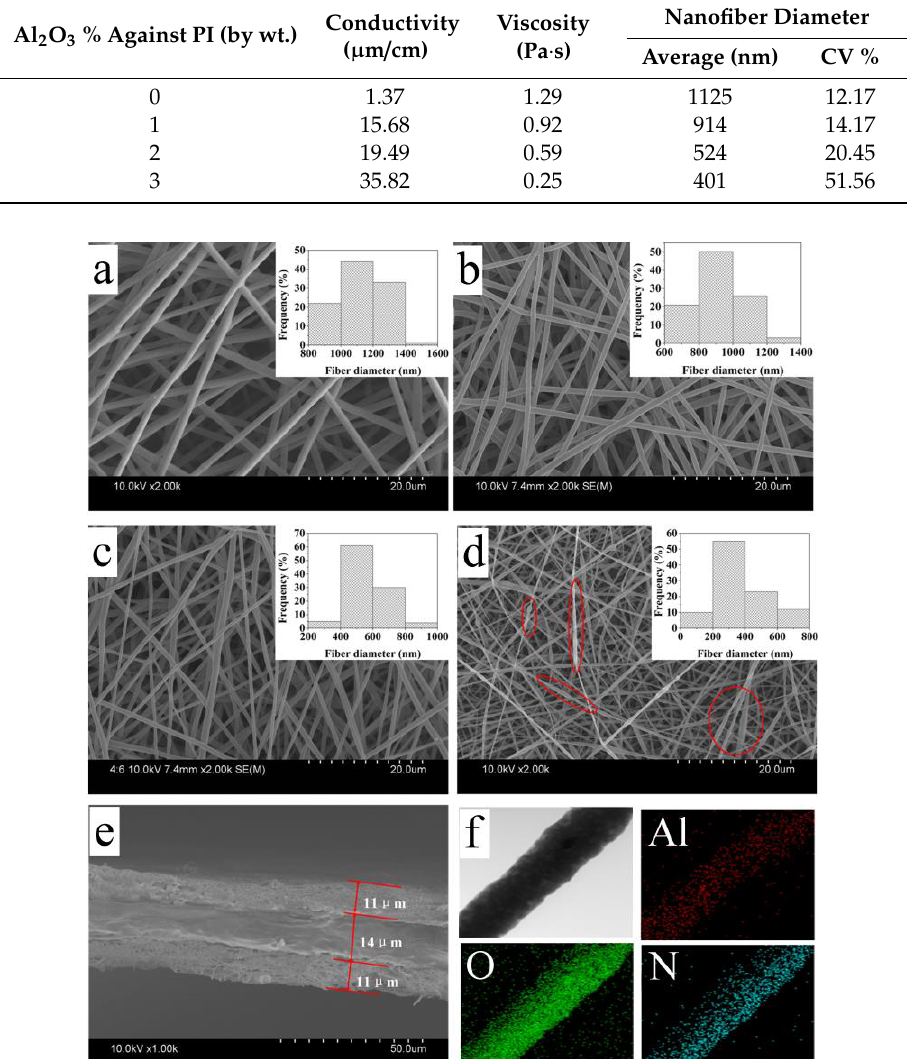
Figure 3. The SEM images of PI with different nanoparticle concentration of ( a ) 0%, ( b ) 1%, ( c ) 2%, ( d ) 3%, ( e ) cross-section image of APEAP separator, ( f ) HAADF-STEM (high-angle annular dark field-scanning transmission electron microscopy), and the corresponding EDS (energy dispersive spectrometer) mapping of the Al, O, and N elements in composite nanofibers.